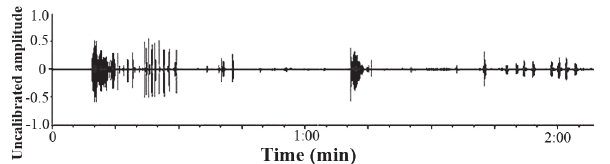
Fig. 2. Oscillogram of pectoral sound (all pulses in the oscillogram) emitted by Iheringichthys labrosus caught in the net in field